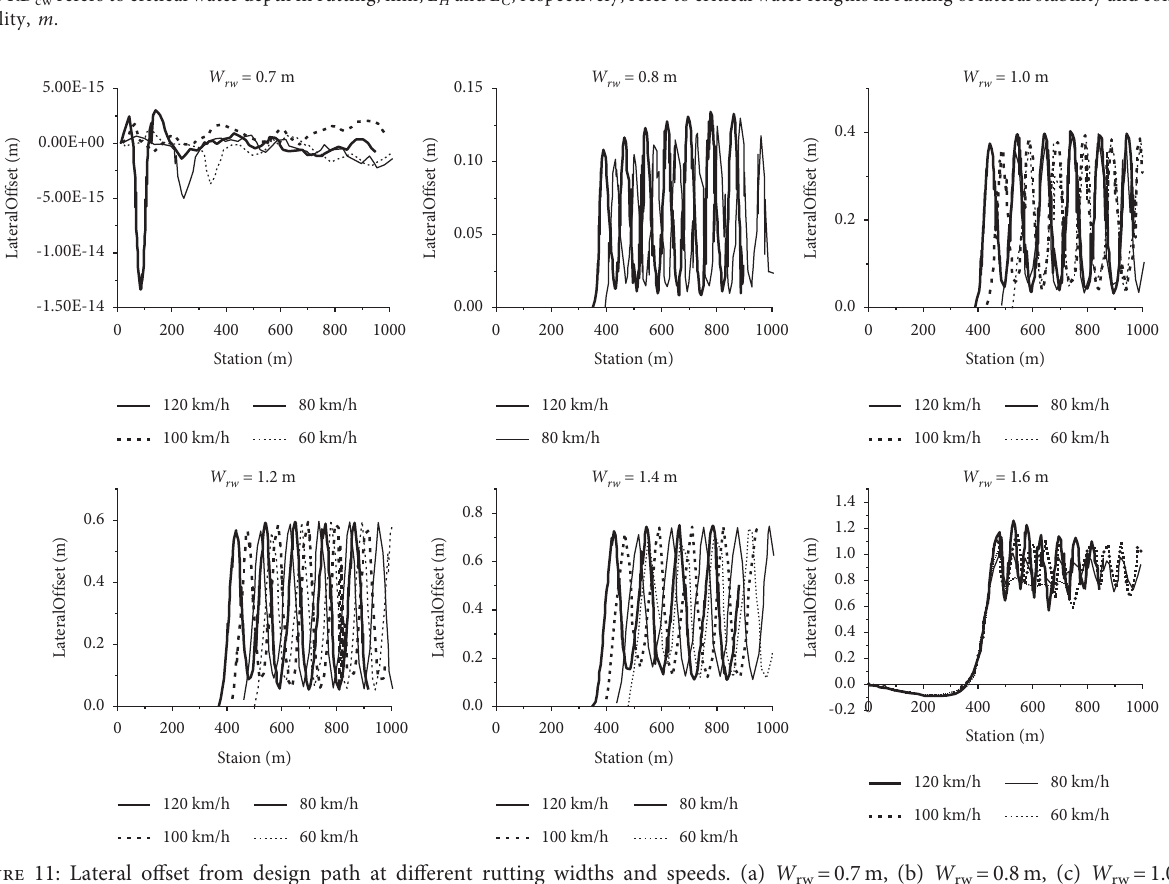
� 0.7 m, (b) W � 0.8m, (c) W � 1.0 m, rw rw rw